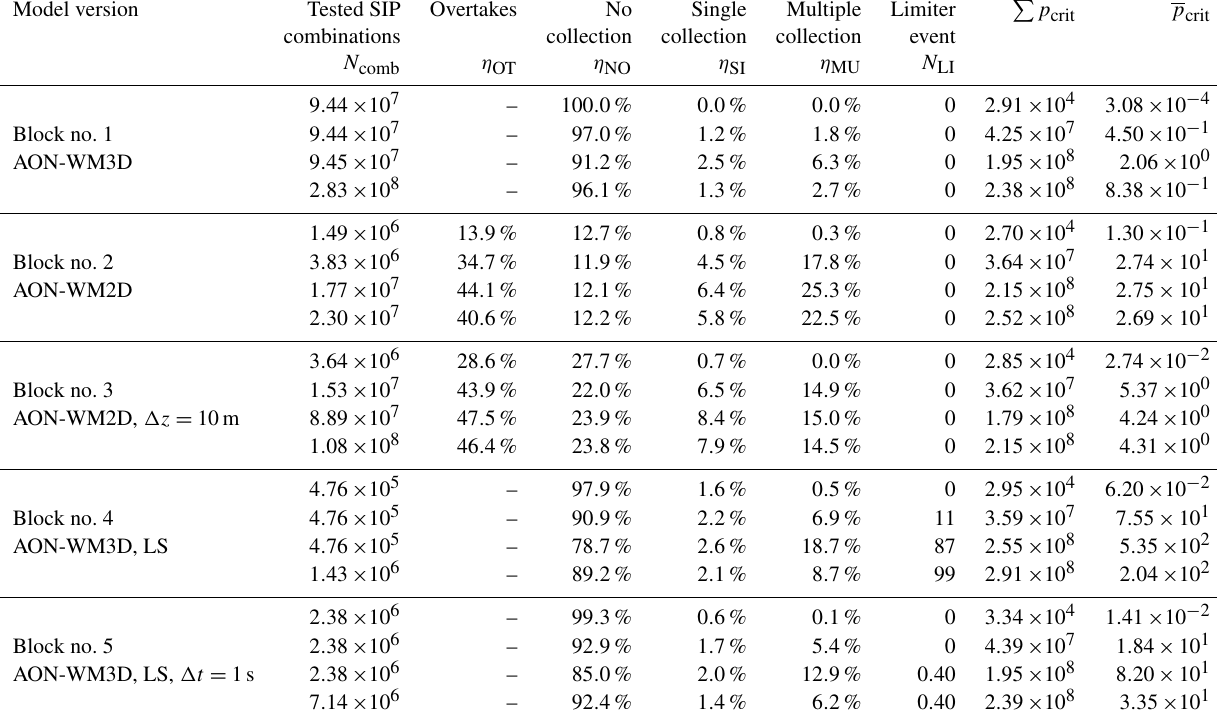
Table 3. BoxModelEmul set-up: a number of events for various AON versions for the parameter set-up given in the text. N comb is the number of tested SIP combinations and N LI is the number of limiter cases, where ν coll had to be artificially reduced. Moreover, η OT , η NO , η SI and η MU specify the number of overtakes, no collections, single collections and multiple collections divided by N comb . The two last columns shows summed-up p crit (summed over all times and SIP combinations and overtakes) and the average p crit . For each AON simulation, the first three rows show aggregate values over three time periods (0–20, 20–40 and 40–60min) and the fourth row values for the full time